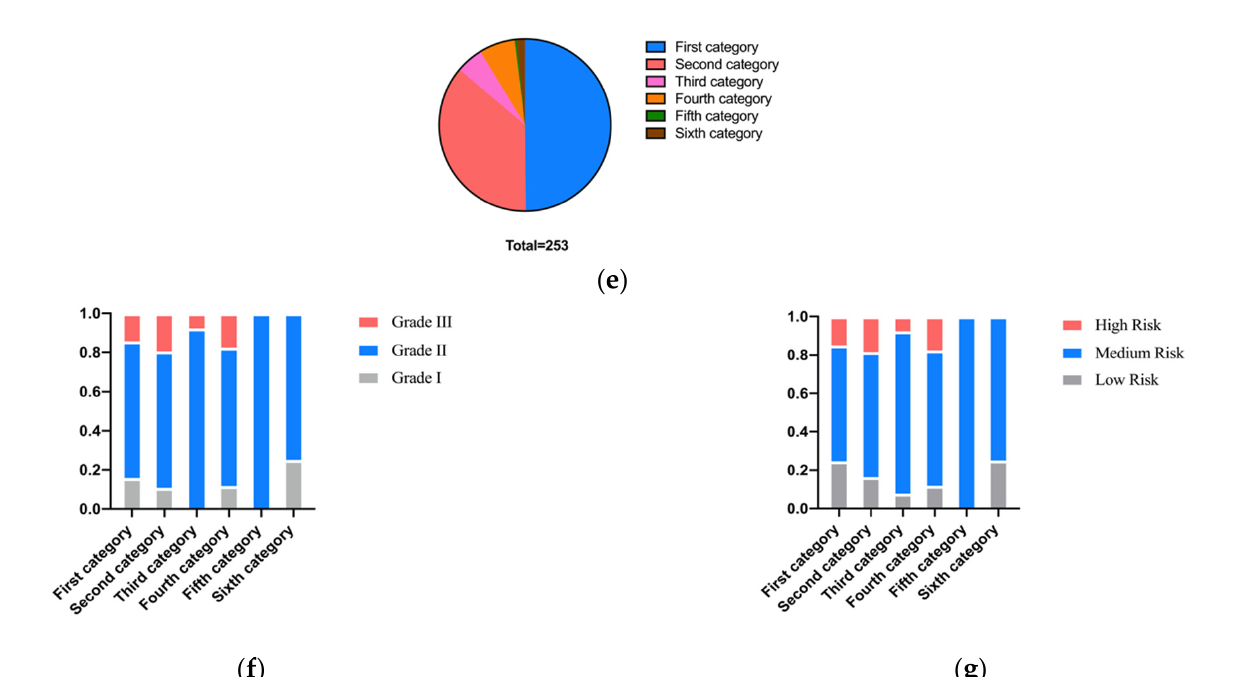
Figure 10. ( a ) Treatment difficulty grade proportion in gender; ( b ) Risk level proportion in gender; ( c ) Proportion of treatment difficulty grades in each age group; ( d ) Proportion of risk levels in each age group; ( e ) Proportion by occupation category; ( f ) Proportion of treatment difficulty grades in each occupational category; ( g ) Proportion of risk levels in each occupational category. The software can collect not only basic information about the patient but also detailed habits that affect the risk of caries and the difficulty of treatment. Therefore, we analyzed some of the patients’ living habits that affect oral environment, hoping to provide some enlightenment for patients’ daily dental health management. According to the chart, we found that those patients who preferred carbonated drinks and sweets had a history of orthodontics and brushed their teeth once or less per day without regular dental exami- nations were more likely to be rated as medium or high risk, Grade II or Grade III treat- ment difficulty (Figure 11a–e).